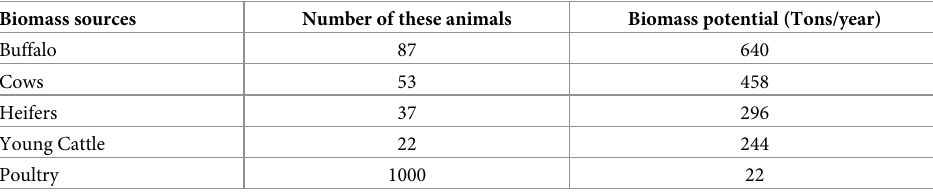
Table 3. Community biomass potential. Biomass